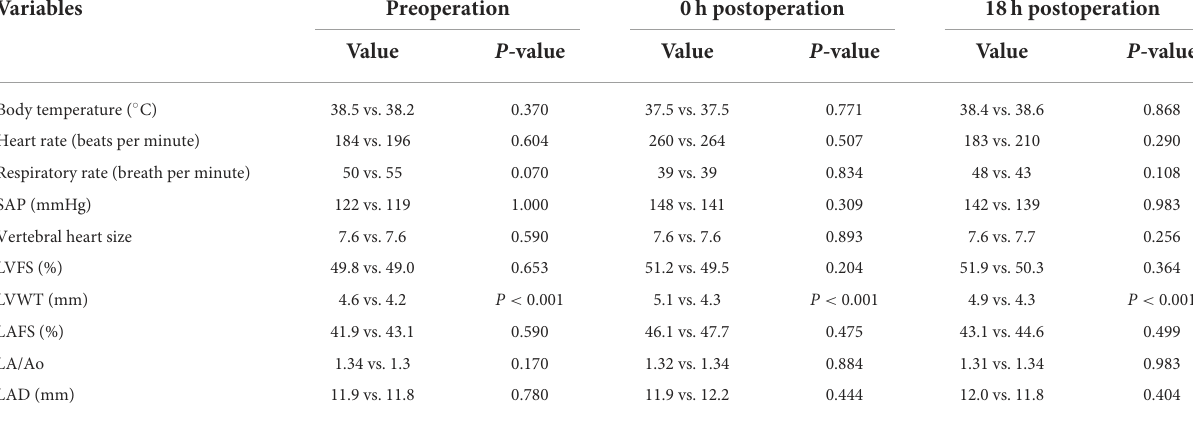
TABLE 3 Comparison of echocardiographical measurement and clinical data between males and females at preoperation, 0h postoperation, and 18h postoperation.